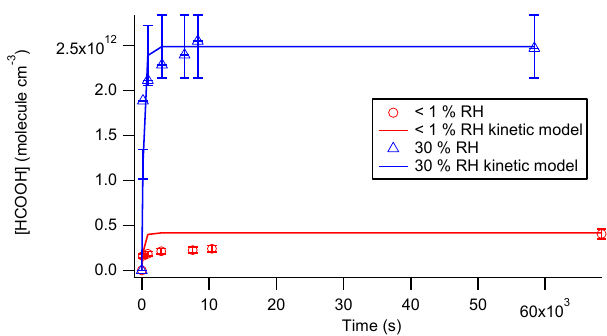
line for ethene ozonolysis under RH < 1 % and 30 % conditions.